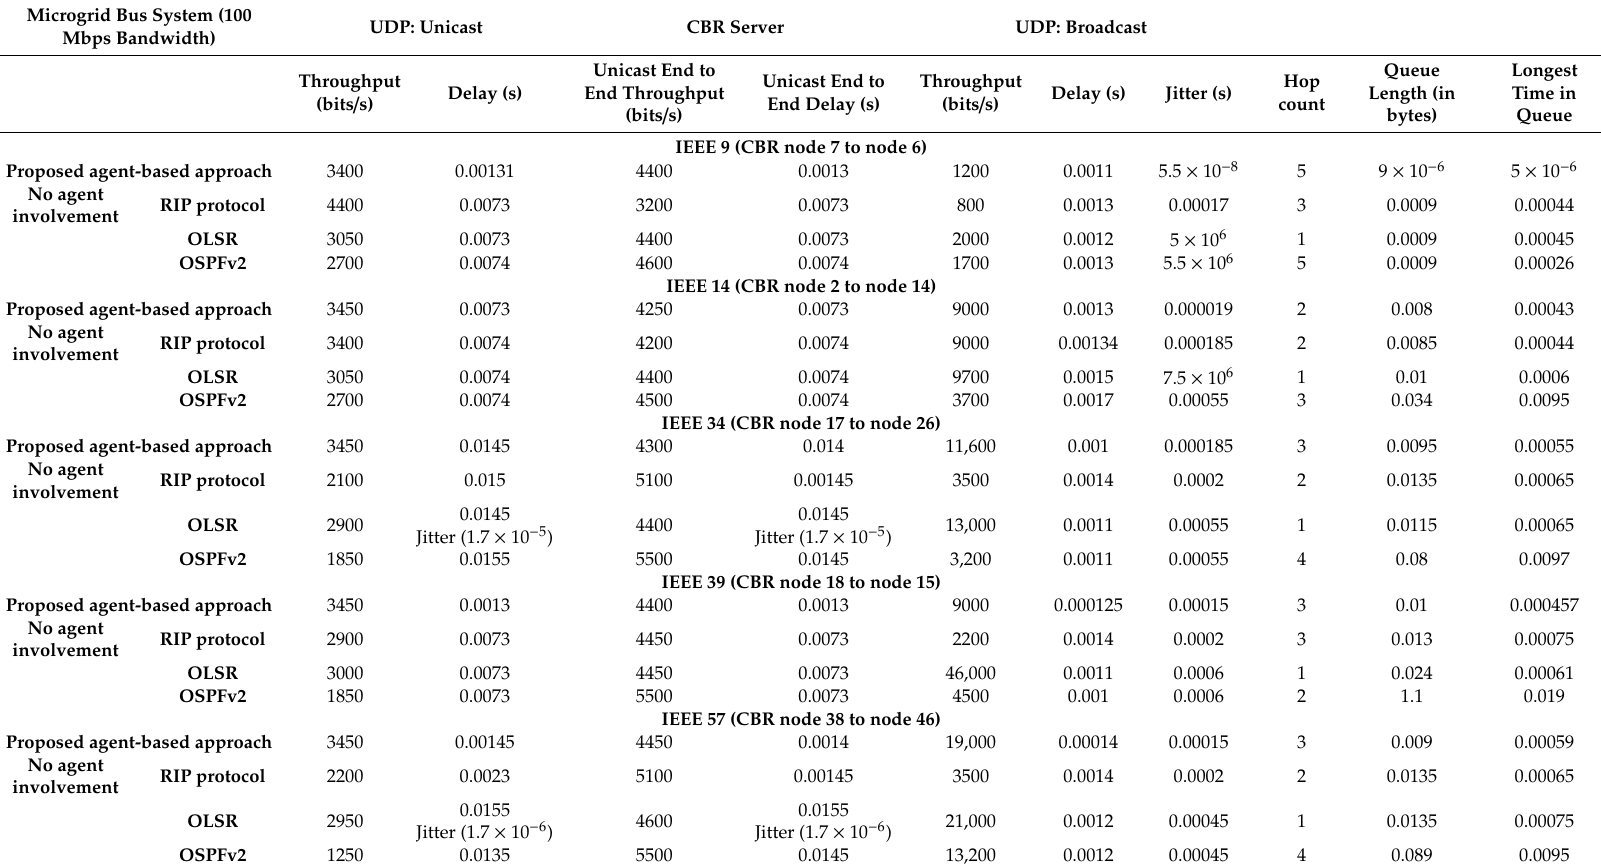
Table 1. Performance evaluation of the bus system for the ideal microgrid communication